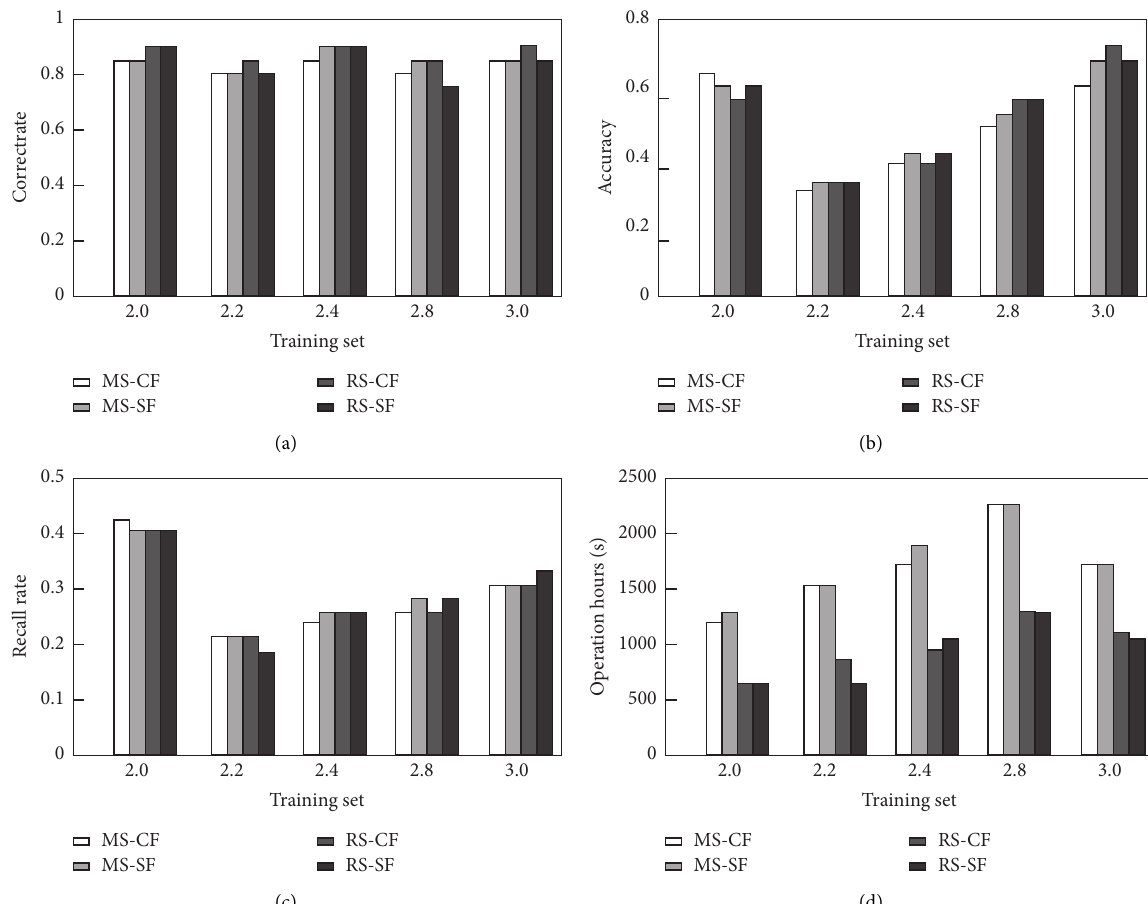
Figure 8: Comparison of cascaded forest and stacked forest: (a) comparison of accuracy prediction; (b) accuracy prediction comparison; (c) recall prediction comparison; (d) comparison of running time